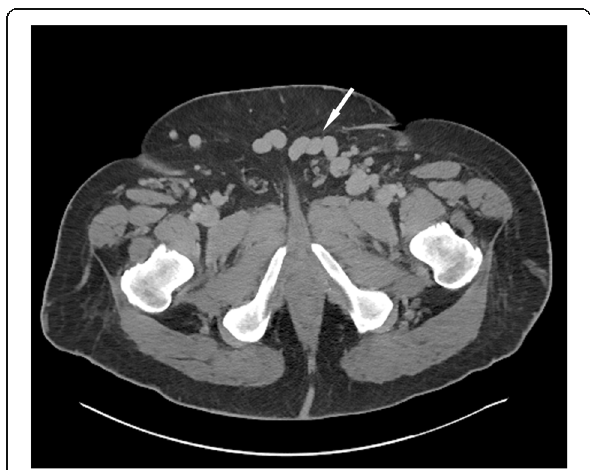
Fig. 1 Axial CT of a 50-year old male presenting with bilateral lower extremity edema and pain. Torturous collaterals connecting the great saphenous veins immediately proximal to the saphenofemoral junctions are noted coursing through the anterior pelvic wall adipose tissue (white arrow)